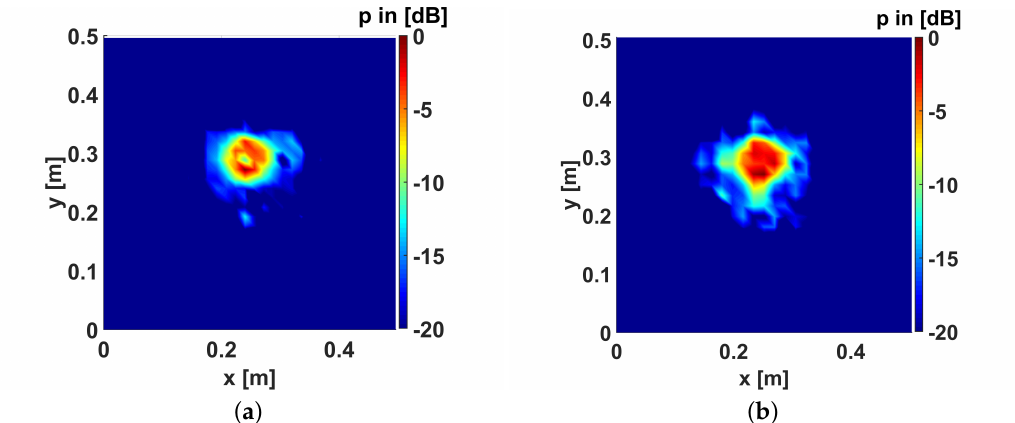
Figure 16. Amplitude at the top of the wooden particleboard with a ø20 mm piece of paper. Evaluated with the spec-radiation method, for the frequency 48–52 kHz, with ( a ) d x = d y = 16 mm and ( b ) d x = d y = 18 mm and a grid of the size 512 mm × 512